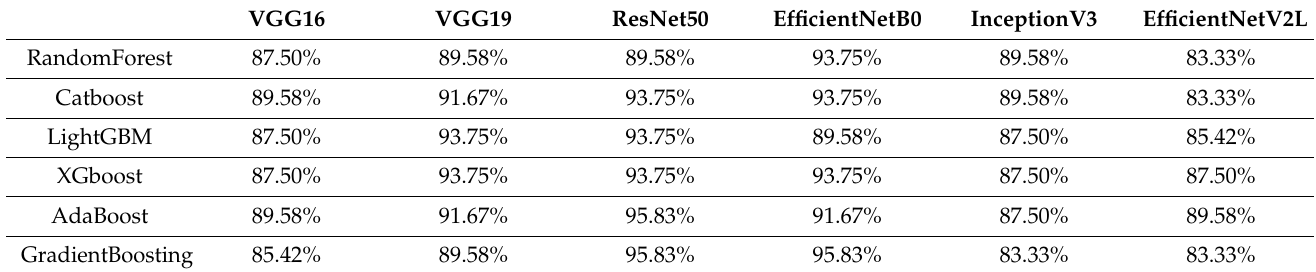
Table A12. Accuracy of each model combination for green stars.